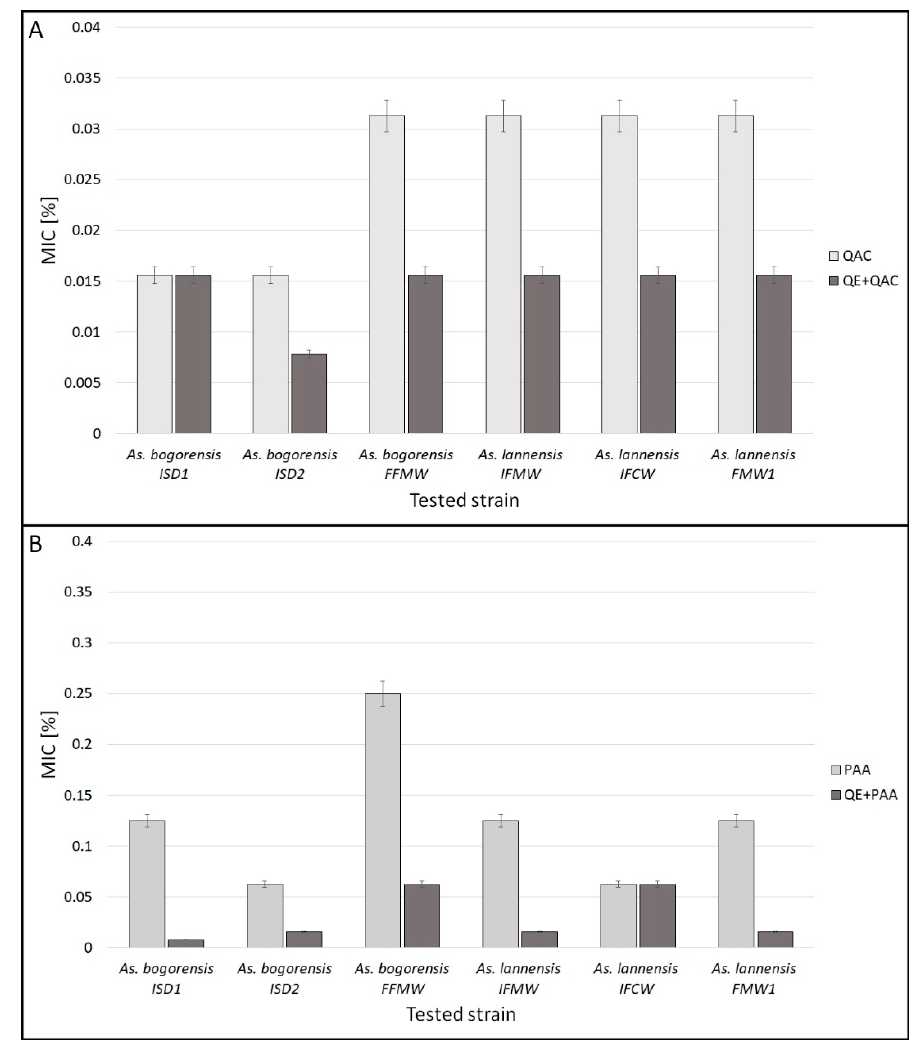
Figure 1. Values for minimal inhibitory concentration of: ( A ) N ‐ ethyl ‐ N , N ‐ dimethylhexadecylammonium bromide (QAC) and ( B ) peracetic acid (PAA) against Asaia spp. in comparison to values obtained for saponin pretreated cells by Q. saponaria extracts (QE): QE + QAC and QE + PAA.